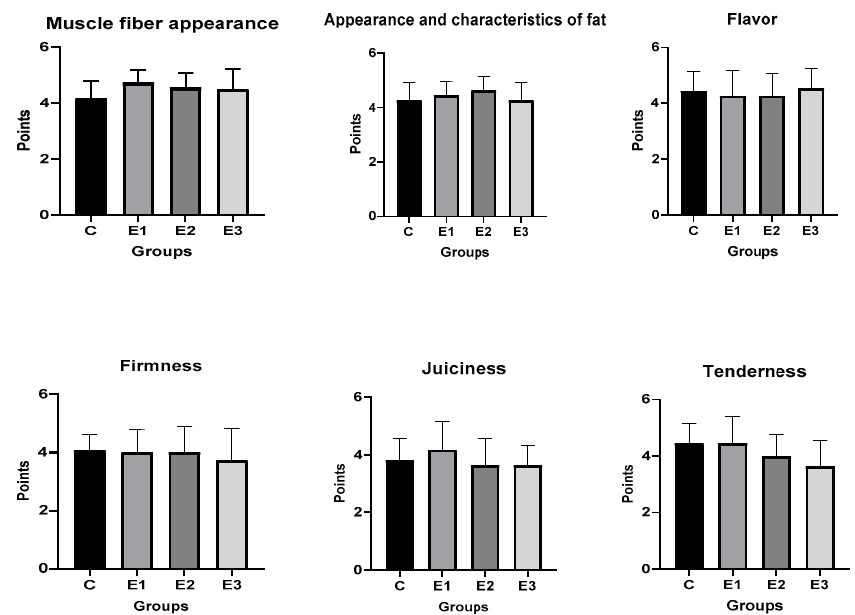
Figure 2. Sensory characteristics of chicken’s breast (mean of points). Main effects of diets are presented in each graph (Prism Graph 9.02). Data are presented as mean ± SEM (n = 6 samples/group). No superscript denotes any statistical significance ( p > 0.1234). C: control diet; E1: experimental diet supplemented with 200 µg/kg diet CrPic + 0.25 g vitamin C (VC)/kg diet; E2: experimental diet supplemented with 200 µg/kg diet CrPic + 0.025 g Zn/kg diet; E3: experimental diet supplemented with 200 µ g/kg diet CrPic + 10 g creeping wood sorrel powder (CWS)/kg diet.